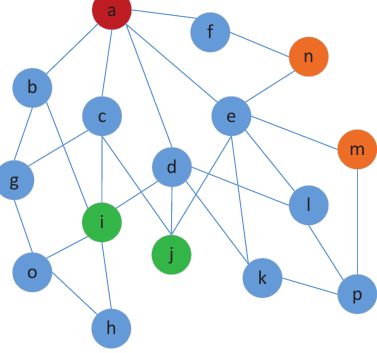
Figure 1. Different number of common neighbors showing different distances.